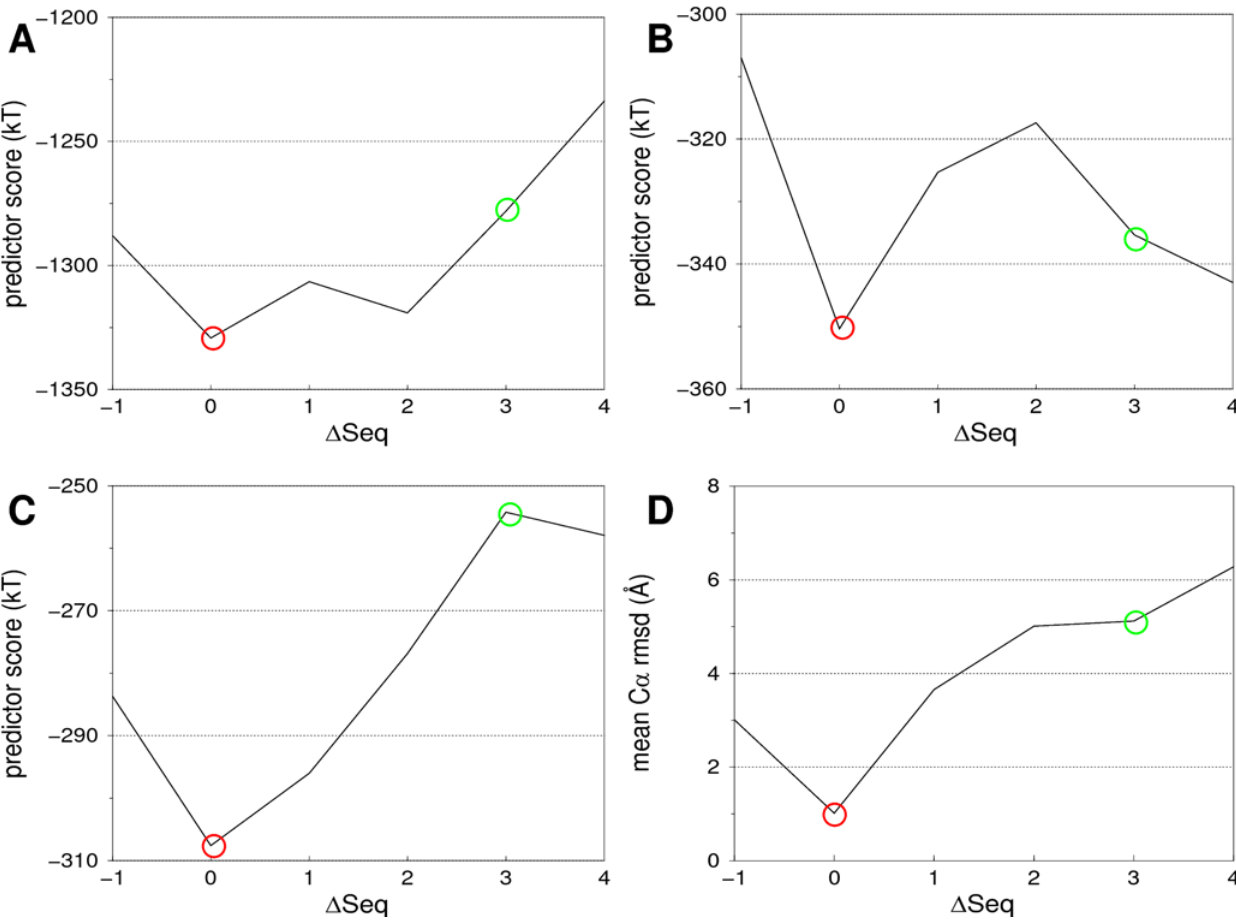
Figure 8. Impact of the distance between the evaluated alignment and the reference alignment (:seq, X axis) on the three ANOLEA- based predictors (Y axis), for T0178 helix 7 case. The most favorable predictor score is indicated by a red circle and the structural alignment by a green circle. A , Predictor ANOLEA/All . B , Predictor ANOLEA/ROI Local . C , Predictor ANOLEA/SSE Local . D , M e an X a RMSD in the region of interest of the models to crystal structure for each